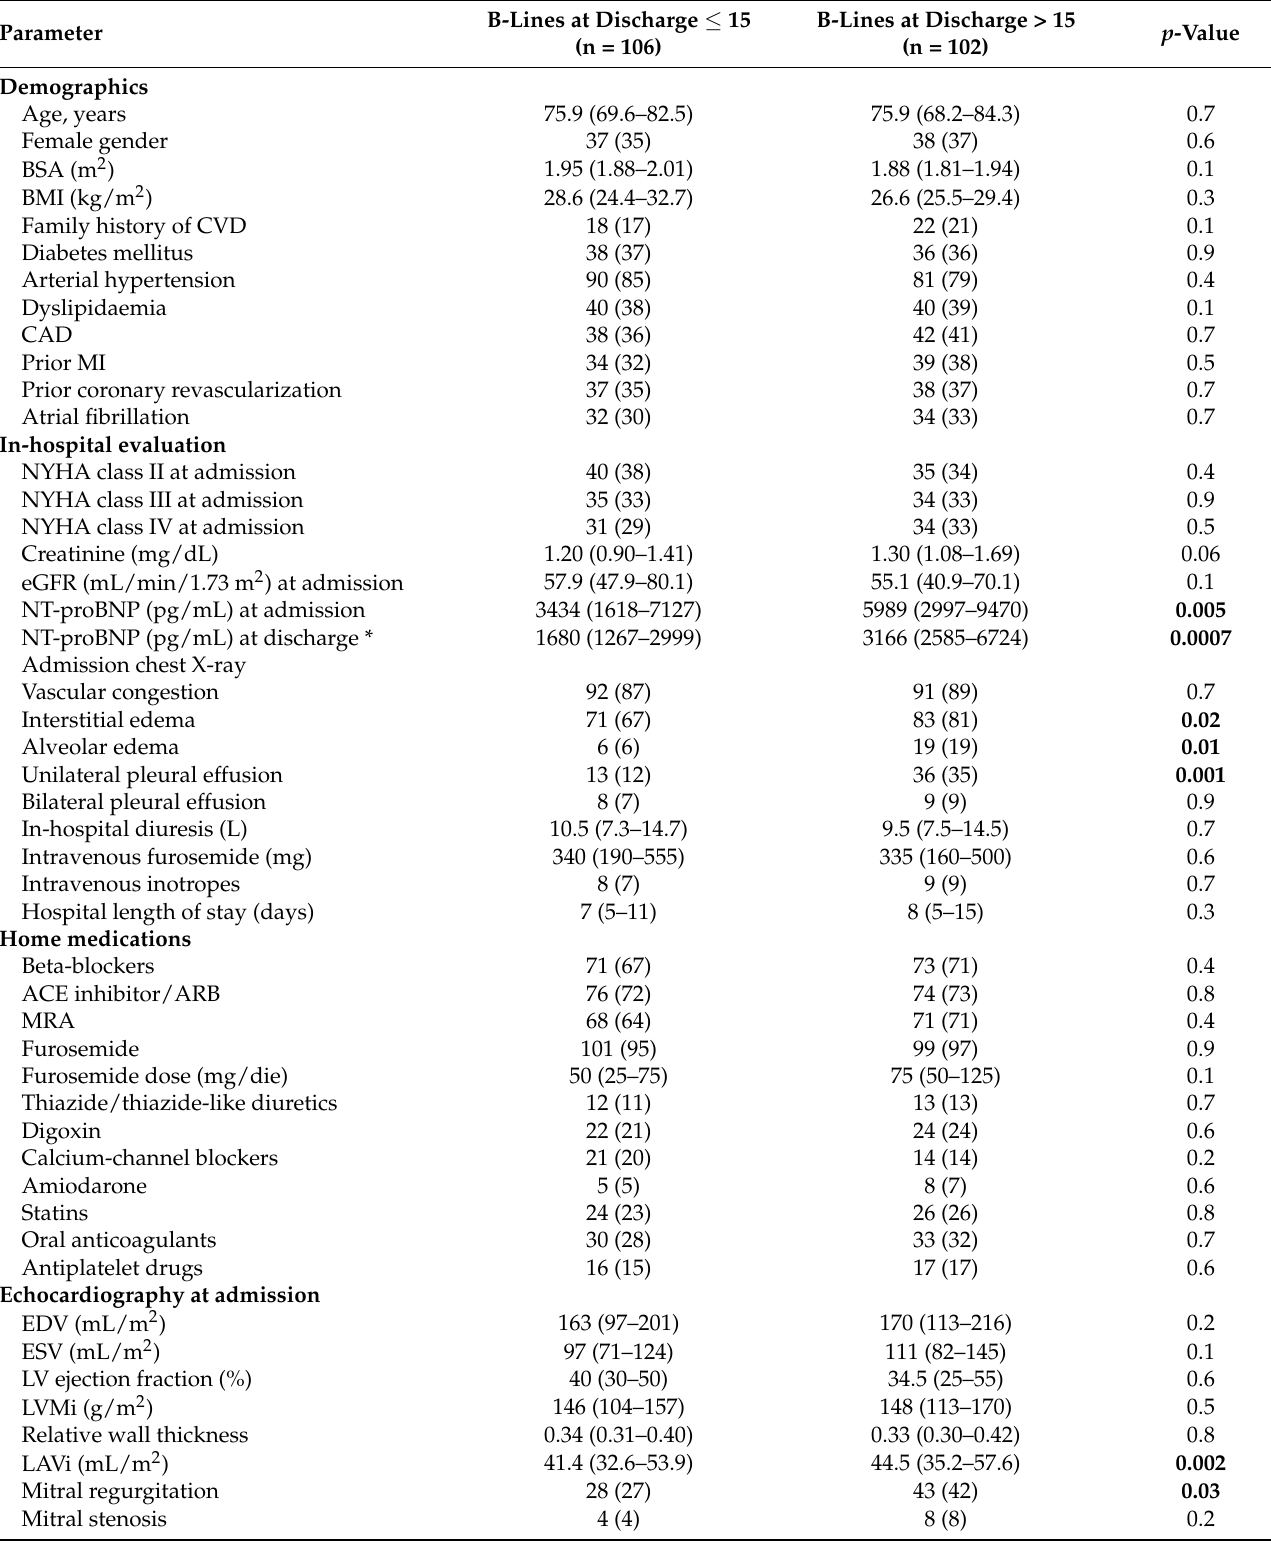
Table 3. Distribution of clinical and ultrasound parameters considering B-lines at